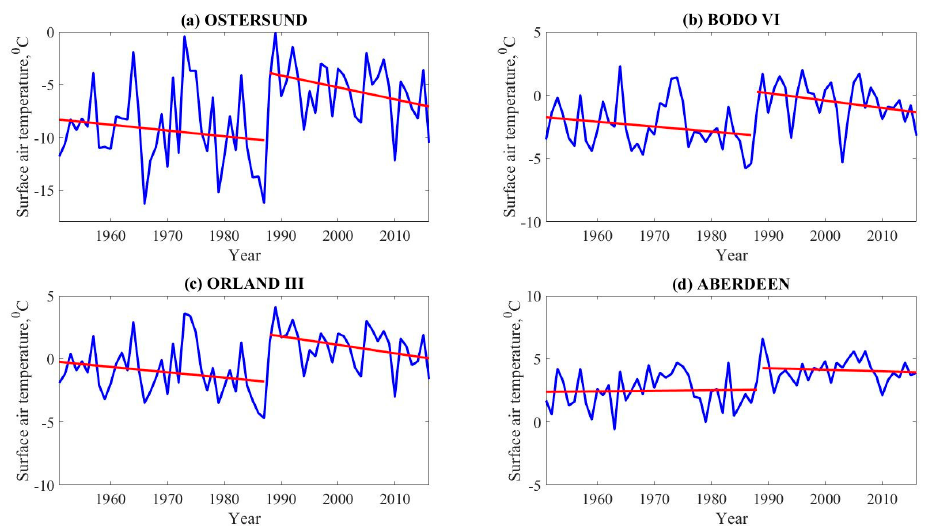
Figure 3. The model of stepwise changes for the SAT in January at the weather stations, ( a ) Ostersund, ( b ) Bodo VI, ( c ) Orland III and ( d ) Aberdeen.